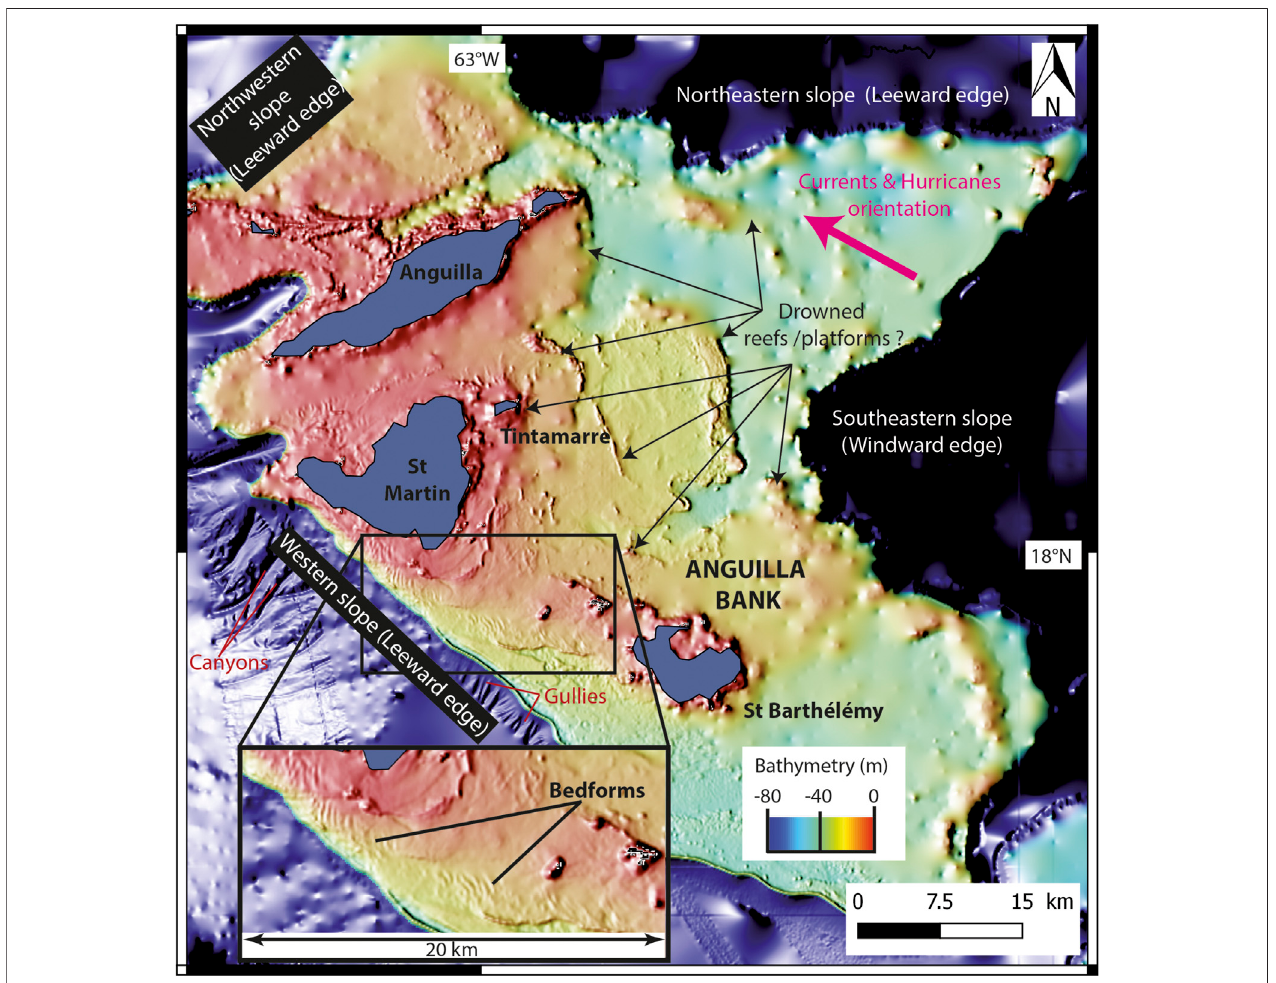
FIGURE 3 | Illustration of the Anguilla Bank with shallow-water bathymetry from the SHOM (2018). A sediment wave fi eld on the shelf presents bedforms with an orientation N-S south of St Martin Island and NW-SE towards the St Barthélémy Island.